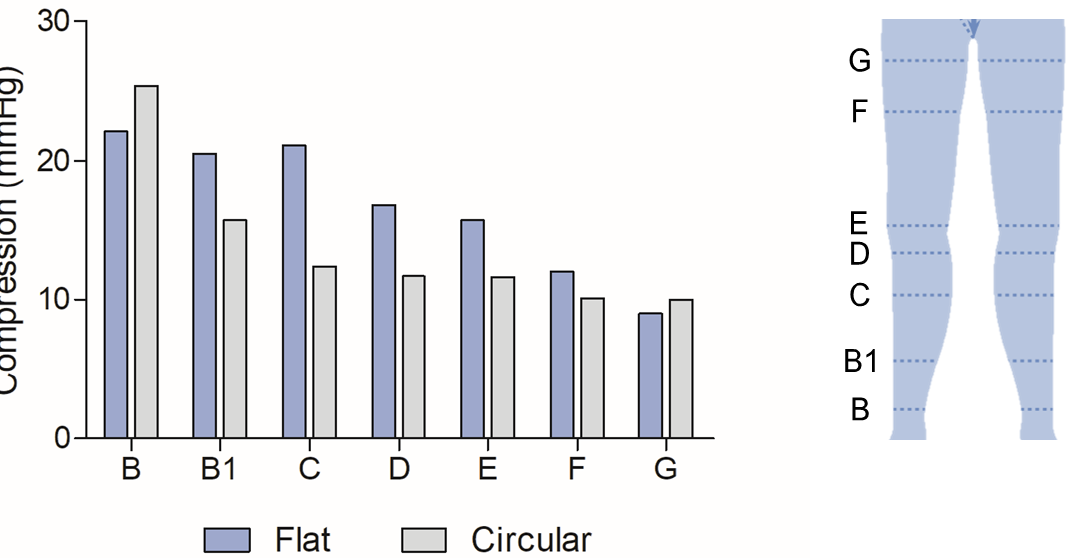
Figure 3. Average compression values of the prototypes measured in the system MST MK V, Swisslastic Ag St, Gallen, Swiss. Reference points of each measurement point extracted from [12].